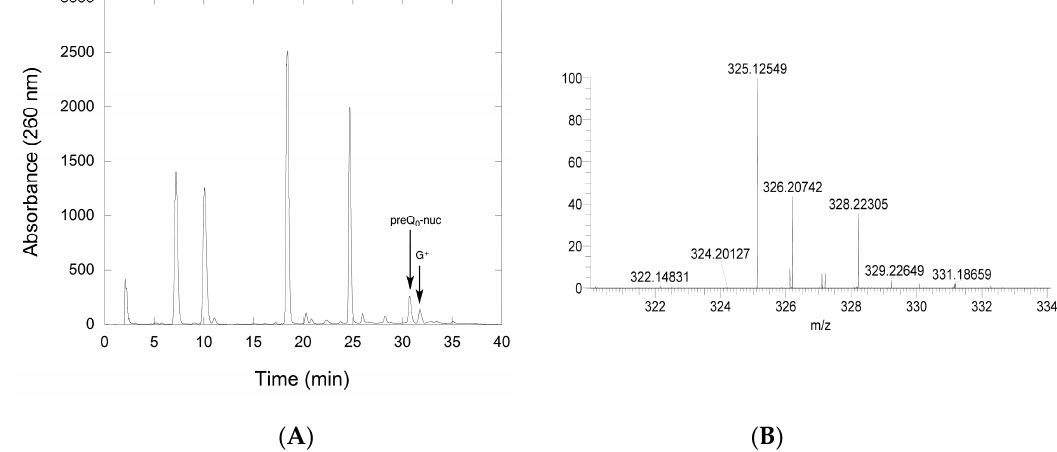
Figure 7. Confirmation of G + synthesis by QueF ‐ L. ( A ) An example of the HPLC chromatogram of nucleoside components of a tRNA Gln transcript modified by incorporation of preQ 0 with arcTGT, followed by reaction with QueF ‐ L in the presence of NH 4 Cl. The tRNA was digested and dephosphorylated prior to HPLC analysis. ( B ) Partial mass spectrum of the component eluting at approximately 32 min and labeled G + in the chromatogram. The peak at m/z 325.12549 is consistent with G + , and the peak at m/z 326.20742 with the isotopic M+1 ion.